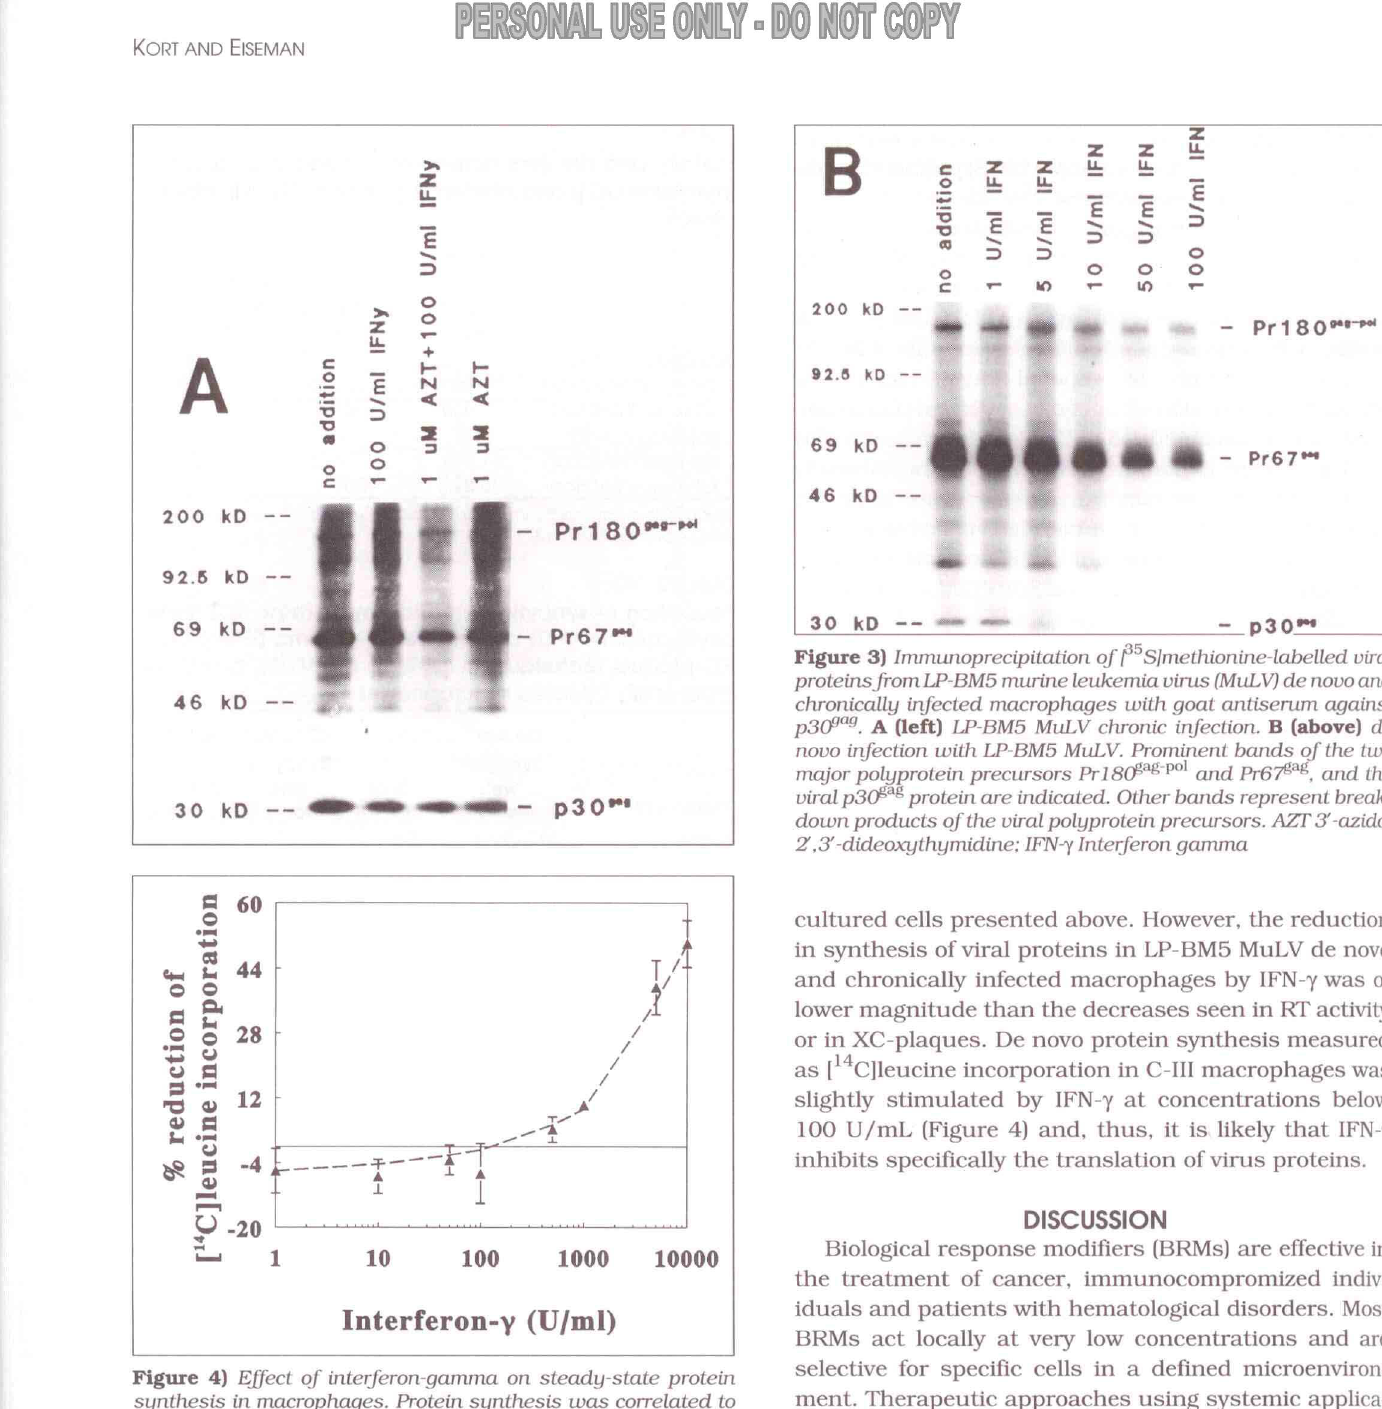
Figure 4) Effect of interferon-gamma on steady-state protein s~nthesis in macrophages. Protein synthesis was correlated to {1 C]leucine incorporation. Data are expressed as percentage reduction of{ 14 C]Leucine incorporation compared with untreated cells (ordinate). Negative values indicate increased { 14 C]Leucine incorporation compared with untreated cells. Symbols represent mean± SD of duplicates from three separate experiments